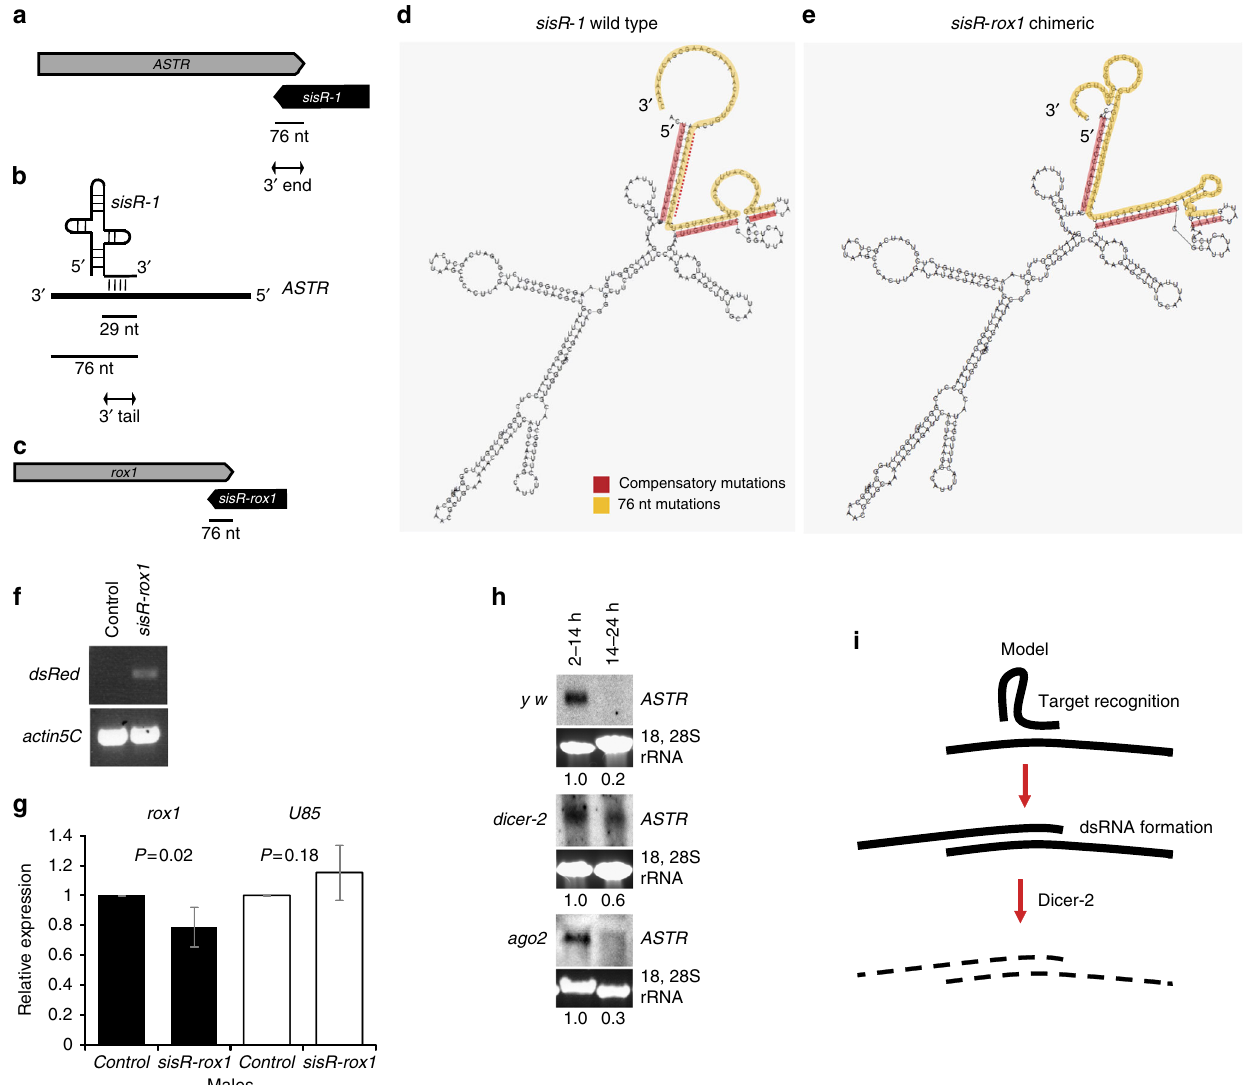
Fig. 4 A model for sisR-1 -mediated silencing of ASTR . a Drawing showing that sisR-1 and ASTR can form a 76 nt dsRNA at the 3 ʹ ends. Not drawn to scale. b Drawing showing the targeting of ASTR by the 3 ʹ tail (29 nt) in sisR-1 . c Drawing showing that sisR-rox1 and rox1 can form a 76 nt dsRNA at the 3 ʹ ends. Not drawn to scale. d , e Predicted secondary structures of d wild-type sisR-1 and e chimeric sisR-rox1 . Orange : region of 76 nt that base pairs with rox1 . Red : compensatory mutations introduced to maintain the secondary structure. f RT-PCR showing the expression of sisR-rox1 transgene in male fl ies. g RT-qPCR showing the downregulation of rox1 ( black bars ) but not U85 ( white bars ) in control versus sisR-rox1 expressing male fl ies. N = 3 – 4 biological replicates. Student ’ s t -test was performed. Error bars represent s.d. h Northern blots (from at least two biological replicates) showing the relative abundance of ASTR between 2 – 14 h and 14 – 24 h embryos in y w control, dicer-2 L811fsX and ago 414 mutants. 18, 28S rRNA was used as loading controls. Numbers below indicate relative band intensities of ASTR normalized to rRNA quanti fi ed using ImageJ software. i A possible model of how sisR-1 may mediate decay of